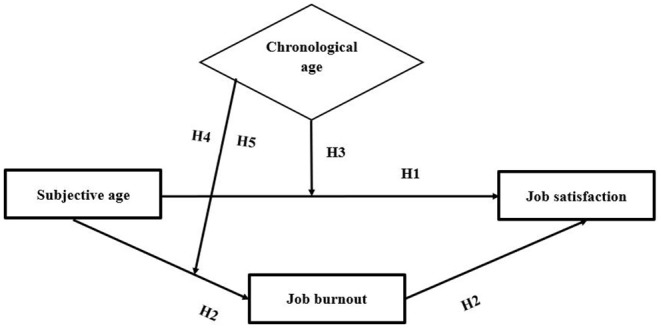
The proposed model.